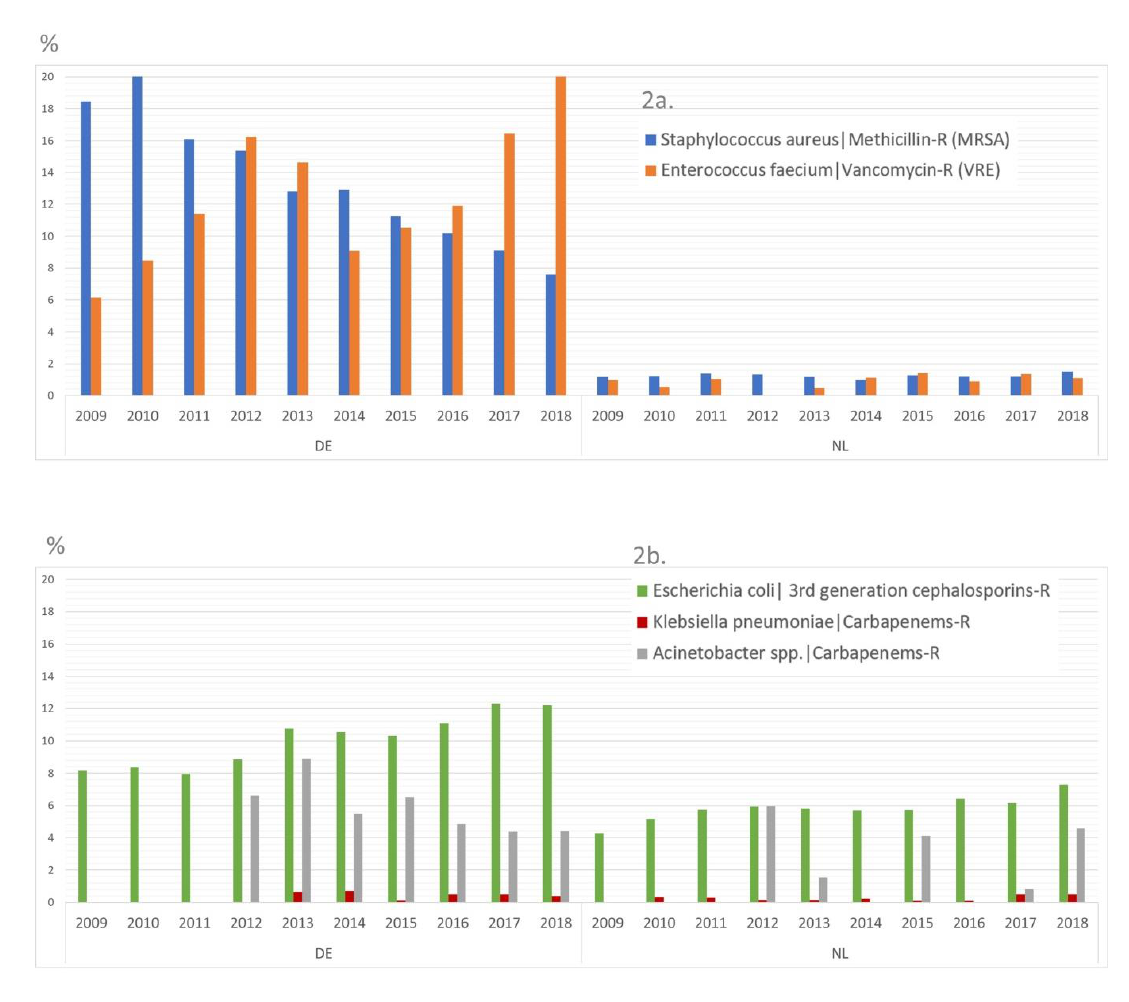
Figure 2. Percentage of resistant isolates from bloodstream infections according to EARS-Net data 2009-2018. ( a ) for methicillin-resistant Staphylococcus aureus (MRSA) and vancomycin-resistant Enterococcus faecium (VRE); ( b ) for third-generation cephalosporin-resistant Escherichia coli, carbapenem-resistant Klebsiella pneumoniae and carbapenem-resistant Acinetobacter spp. Table 1. Estimated median number of cases (incidences per 100,000 inhabitants) and median numbers of deaths (mortality per 100,000 inhabitants) for infections due to MDRO in 2015 [1].